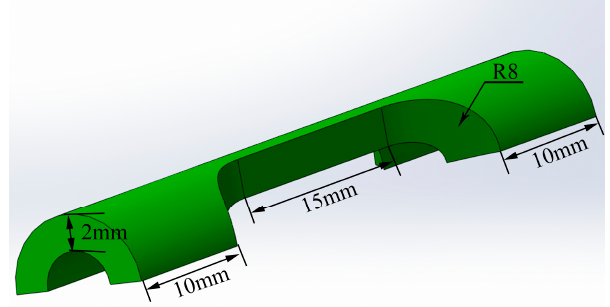
Figure 2. Dimensioned schematic of the tubes tensile specimen.